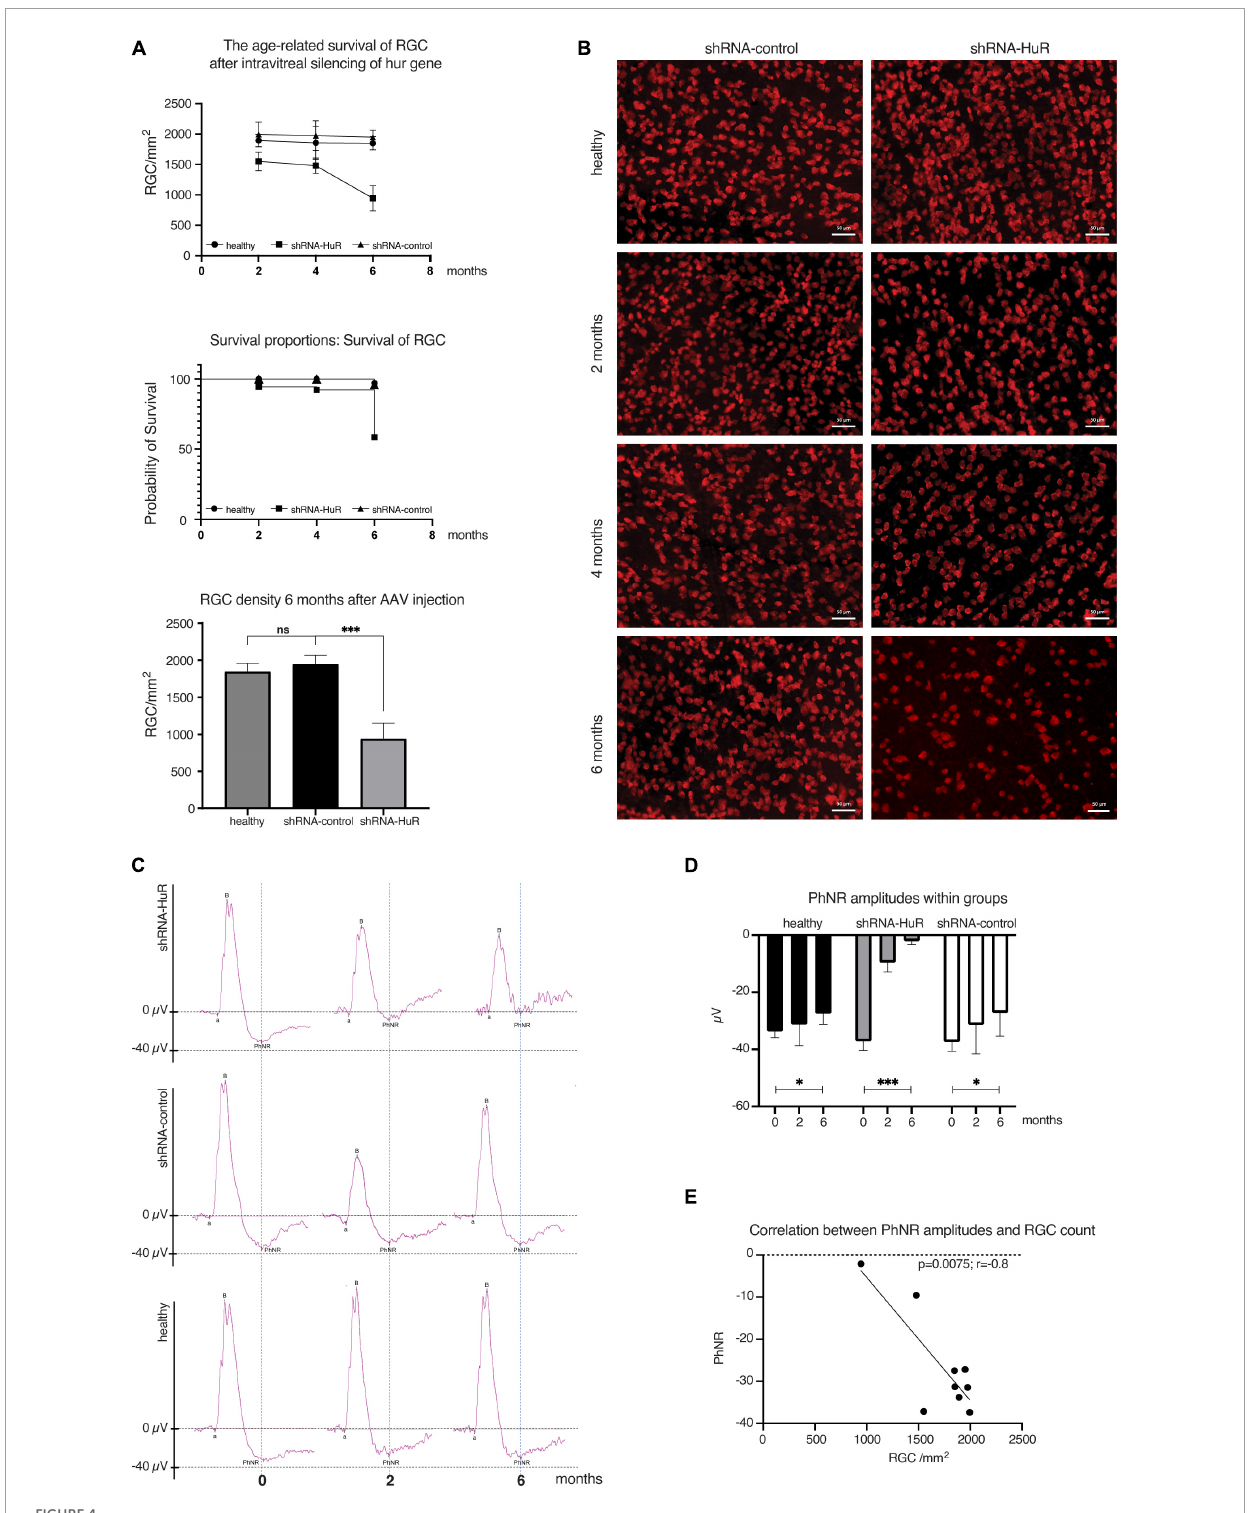
FIGURE4 Age-related degeneration of RGCs—endogenous neuroprotection study. (A) Analysis of the RGC counts, survival curve and significance of RGC loss between groups of animals 2, 4, and 6 months after intravitreal injection of AAV constructs; n = 3 animals per group, 12 micrographs per retina. ns, not significant, ∗∗∗ p < 0.003. (B) Immunofluorescence staining of whole-mounted retinas for RBPMS (RGC marker) in animals sacrificed 2, 4, and 6 months after intravitreal injection of AAV constructs. Morphological differences are clearly visible, especially after 6 months, where in shRNA group, the cell loss seemed to be involving especially small RGC, so there was a higher content of larger-sized RGC observed, when compared with control group. Scale bar = 50 µ m. (C) Averaged recordings of photopic ERGs with an analysis of the photopic negative response (PhNR) wave 2 and 6 months after AAV constructs injection. (D) Statistical analysis of changes in the PhNR amplitude within groups 2 and 6 months after AAV constructs injection; n = 3 animals per group. ∗ p < 0.03 and ∗∗∗ p < 0.003. (E) The correlation analysis between RGC count (morphology) and PhNR responses (function) in animals utilized in experiment. r, correlation